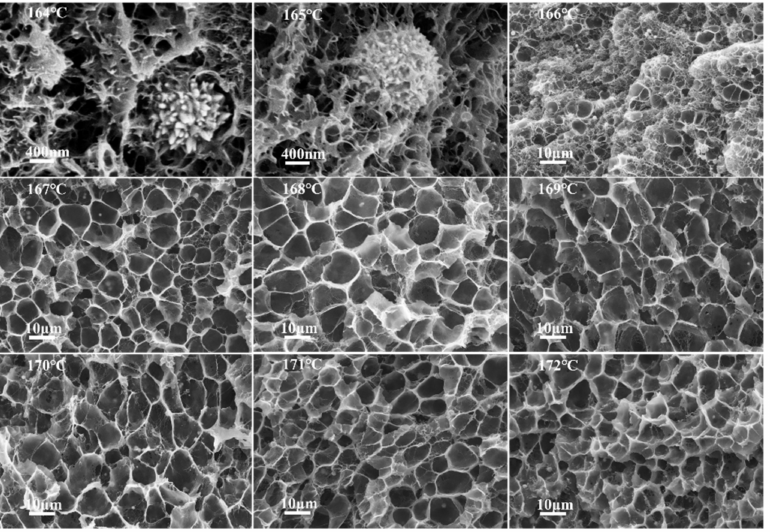
Figure 4. The SEM images of the cross-section of the PVDF/10 wt% CNTs/10 wt% Ni composites foaming under different temperature (164–172 ◦ C). The pictures of 164 ◦ C and 165 ◦ C were taken at a magnification of 20,000, and the others were taken at a magnification of 2000.